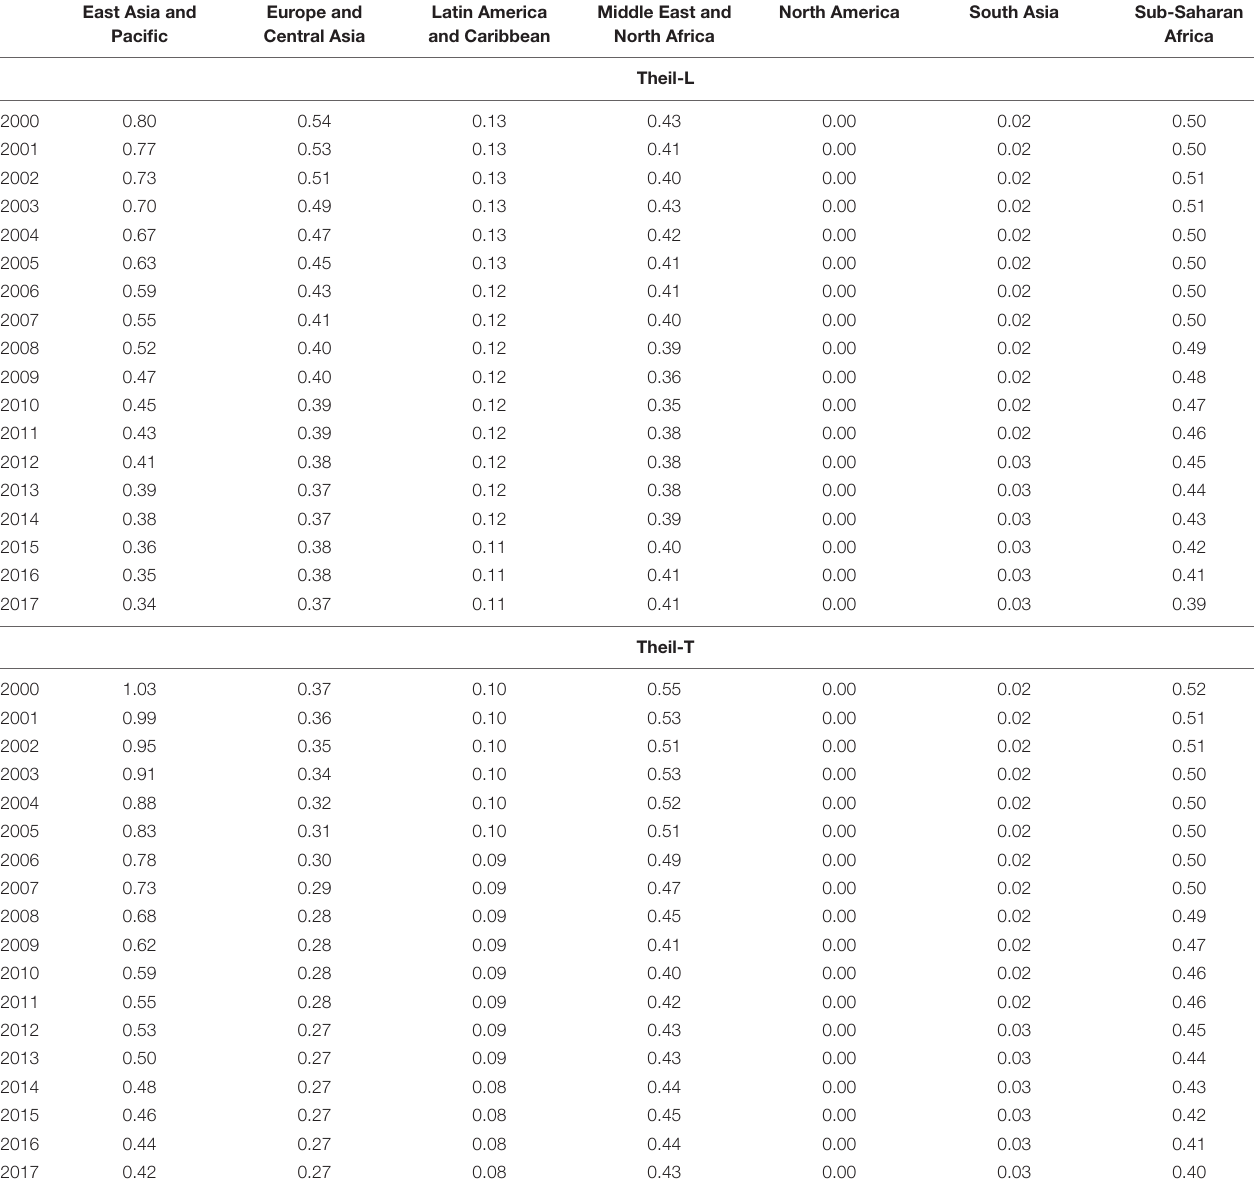
TABLE 2 | Income inequality for seven regional subgroups,